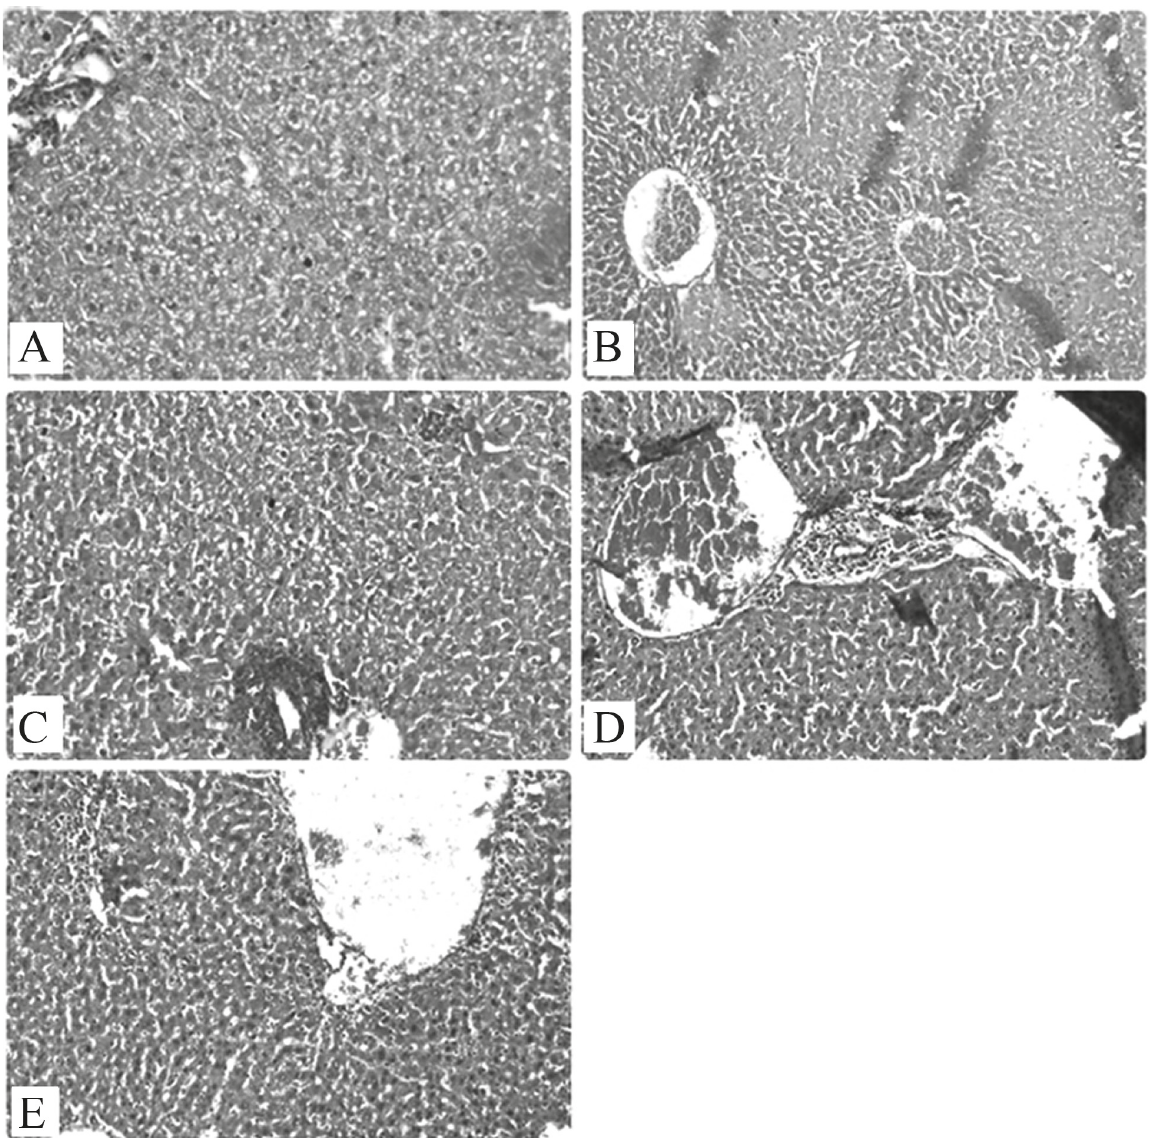
FIGURE 3 - Histopathological examination of study groups treated with [A] distilled water – normal liver architecture and healthy hepatocytes [B] paracetamol – inflammation (score = 3), microvesicular steatosis (score = 1), necrosis, ballooning (score = 3) and sinusoidal constriction of hepatocytes [C] silymarin – improved inflammation, ballooning and necrosis of hepatocytes as mild steatosis (score = 1), negative to microvesicular steatosis, mild inflammation (score = 1) and no balloon cells (score = 0) [D] NHMN 250 mg/kg – inflammation (score = 2), microvesicular steatosis (score = 1) and few balloon cells (score = 1) [E] NHMN 500 mg/kg – inflammation (score = 1), microvesicular steatosis (score = 0) and few balloons cells (score = 1). Scores are referred to histology scores recommended by Pathology Committee of NASH Clinical Research